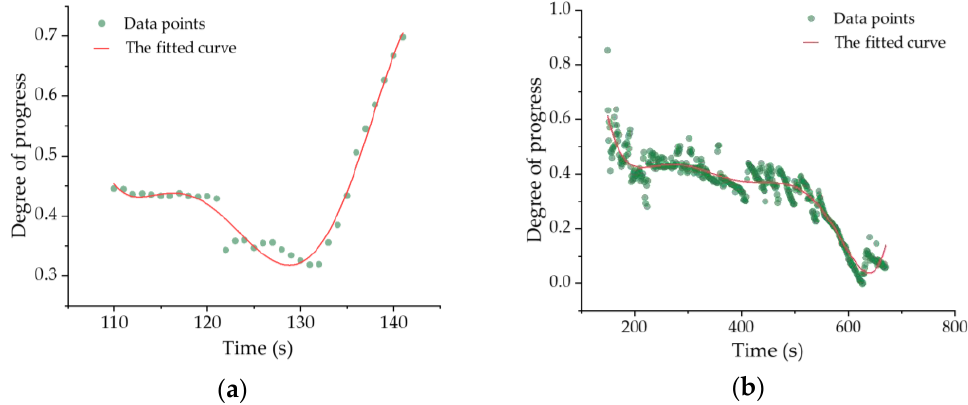
Figure 11. Polynomial fitting results of melting, crystallization progress and time. ( a , b ) are the results corresponding to melting and crystallization, respectively.